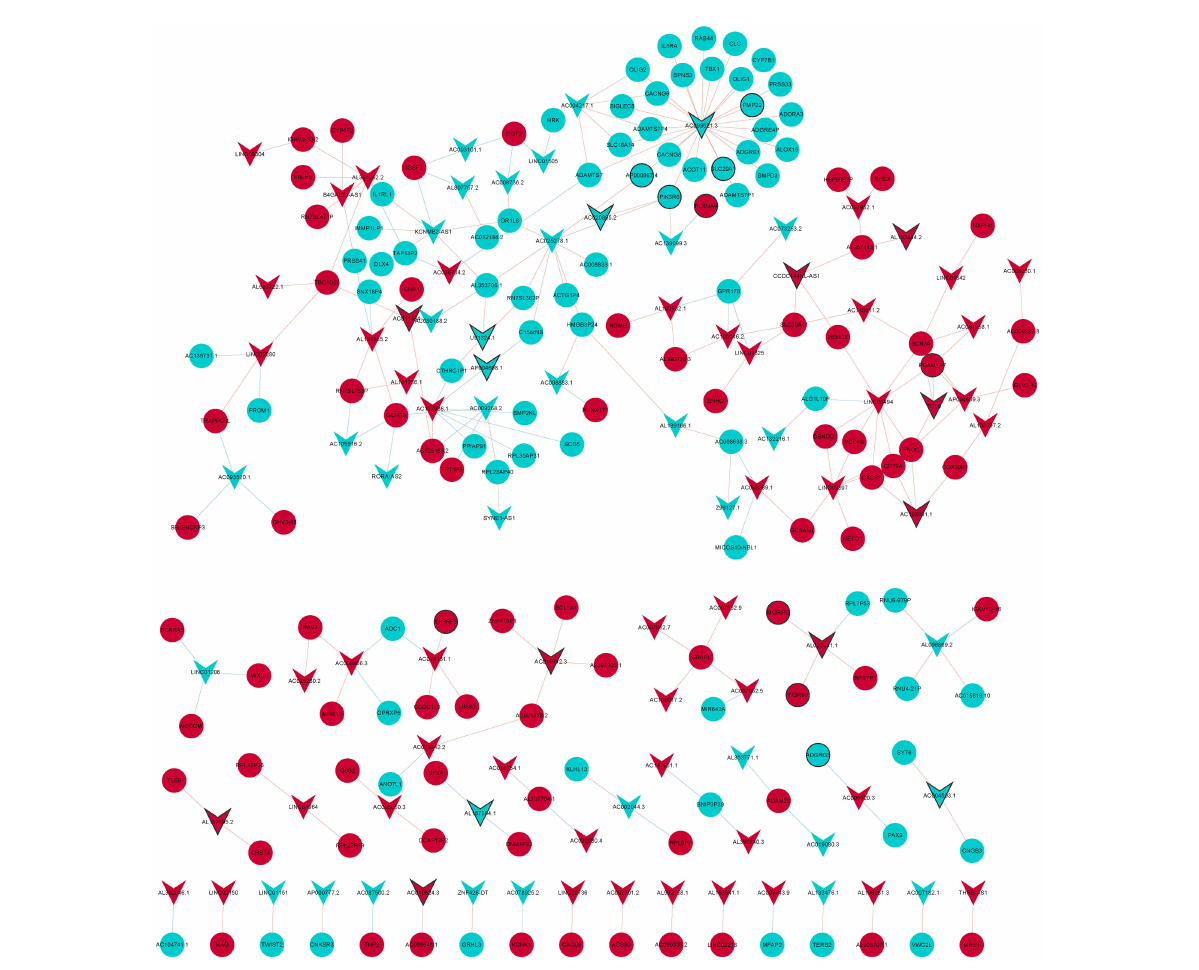
FIGURE4 LncRNA-mRNA co-expression network diagram. Circles and V-shape represent DEmRNAs and DElncRNAs, respectively. Red and wathet represent upregulation and downregulation, respectively. Black borders represent the top 10 up-/downregulated DEmRNAs or